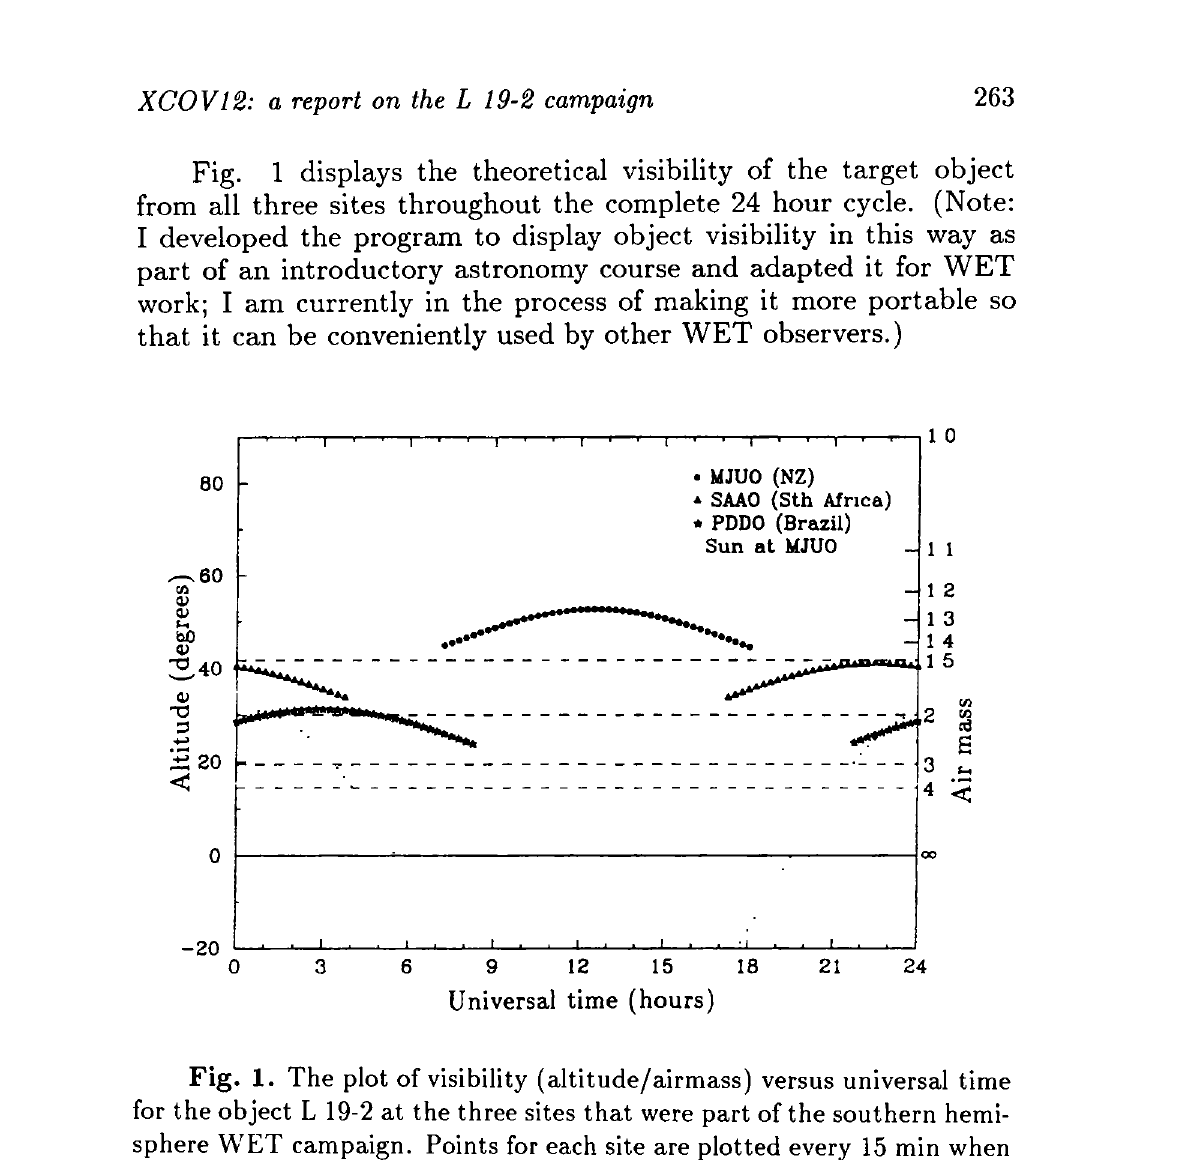
Fig. 1. The plot of visibility (altitude/airmass) versus universal time for the object L 19-2 at the three sites that were part of the southern hemi- sphere WET campaign. Points for each site are plotted every 15 min when the Sun is 15 or more degrees below the horizon. To aid interpretation, corresponding positions of the Sun are provided for the MJUO